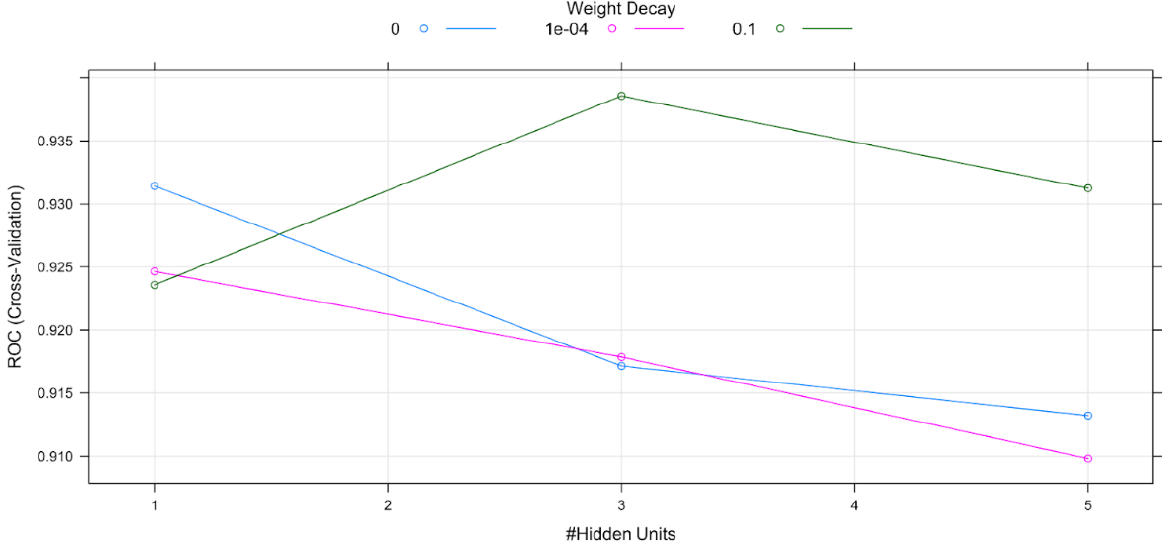
Figure 4. 10-k cross-validation method used to optimize the ANN parameters.